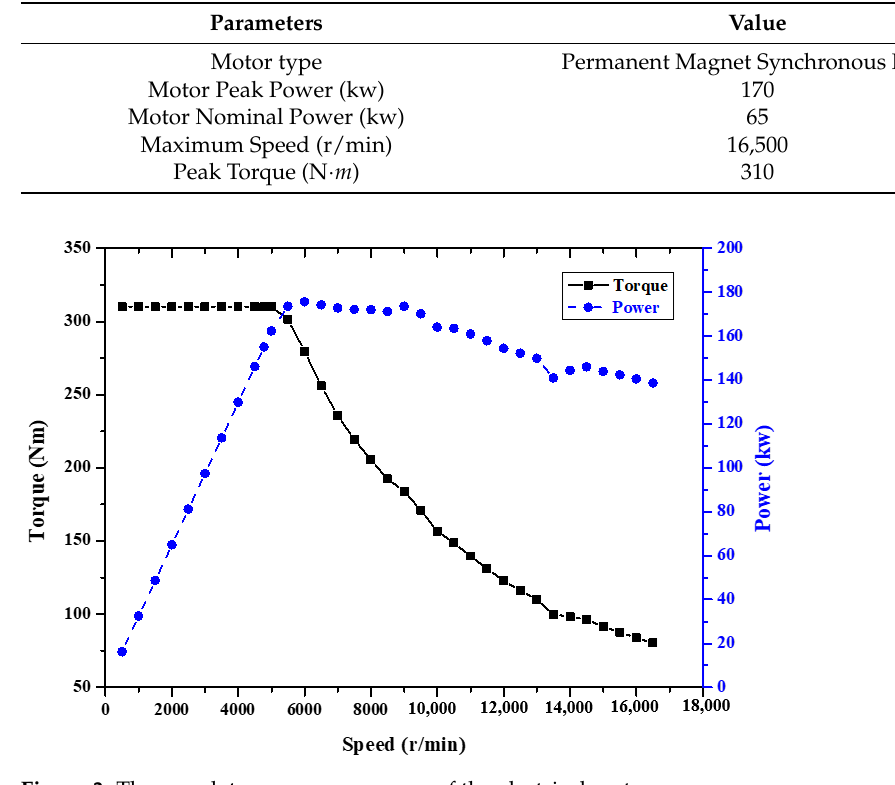
Figure 3. The speed – torque – power curve of the electrical motor. Figure 3. The speed–torque–power curve of the electrical